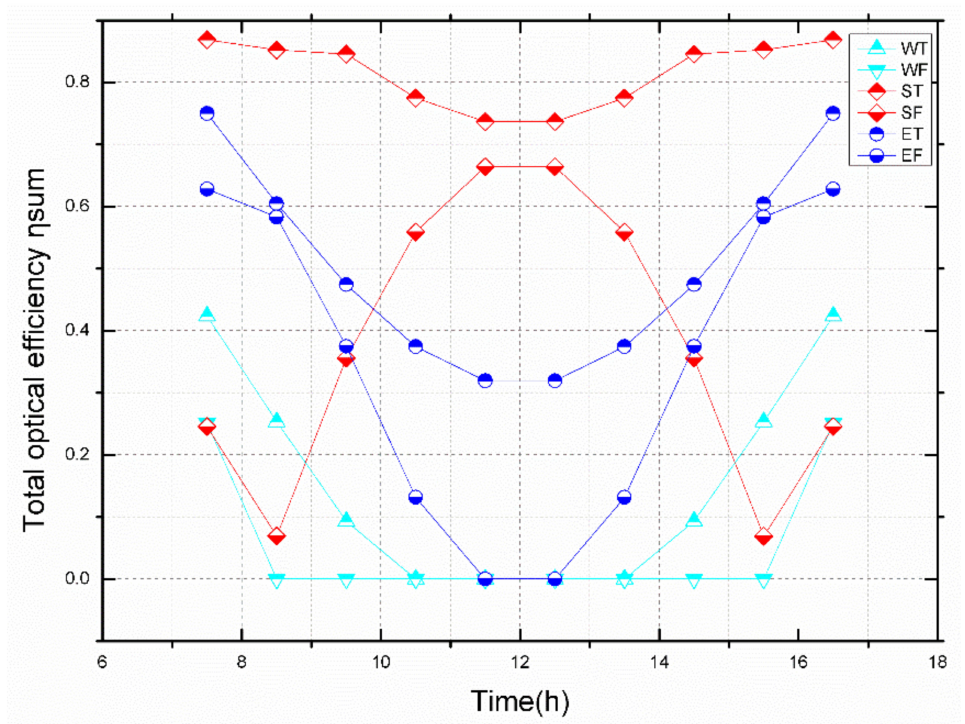
Figure 6. Variation in the reflector optical efficiency with